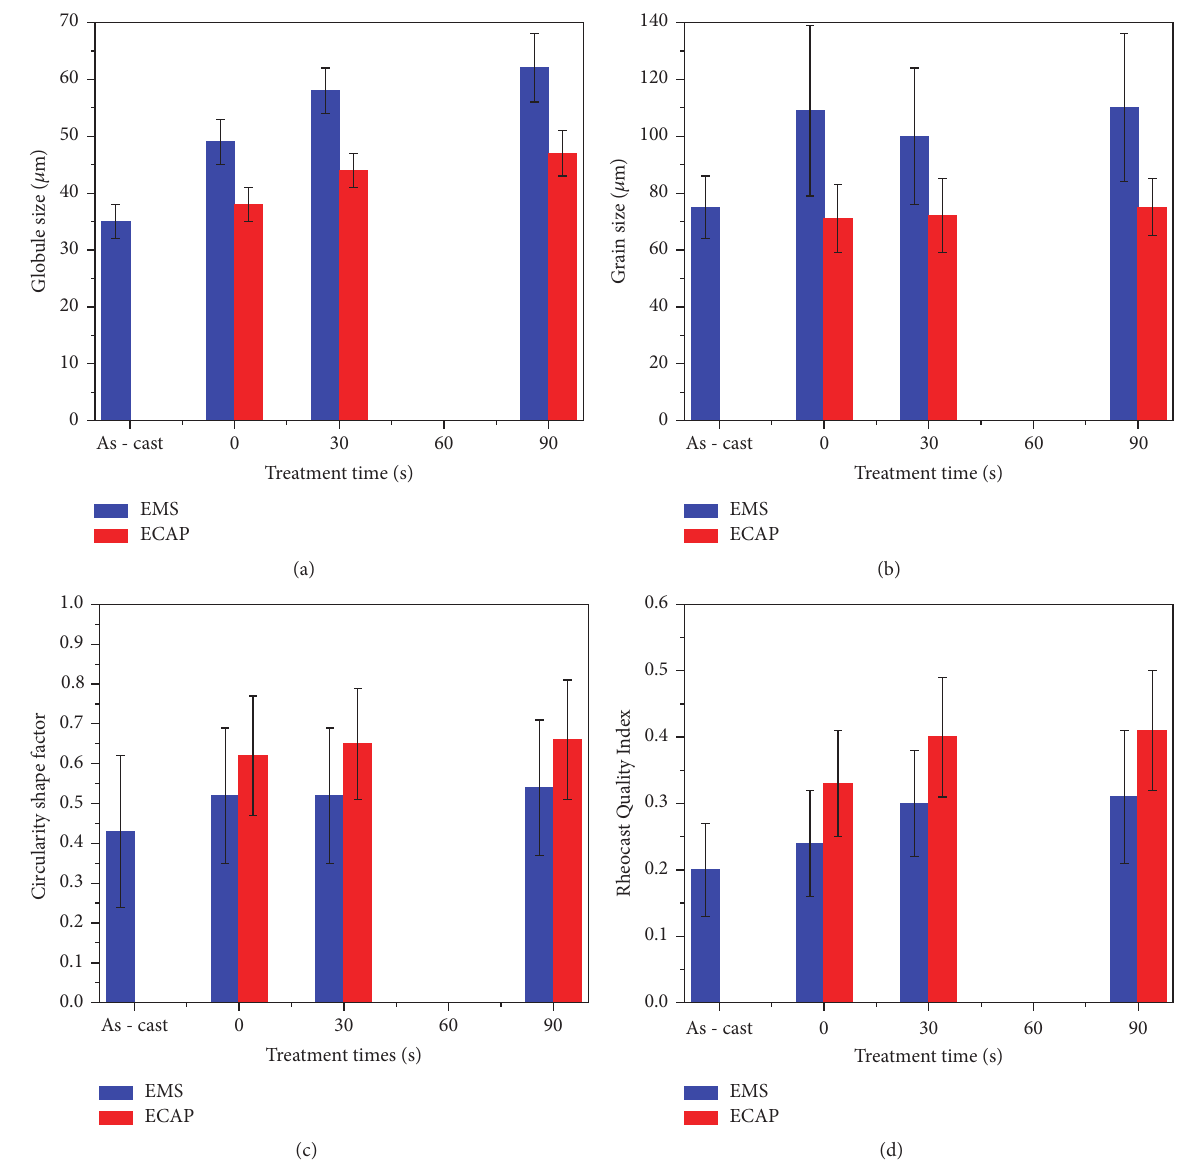
Figure 6: Globule size, grain size, circularity shape factor, and RQI of the Al-4.0wt%Si-2.5wt%Cu samples alloy heat-treated (584 ∘ C) at 60% of solid fraction in 0, 30, and 90